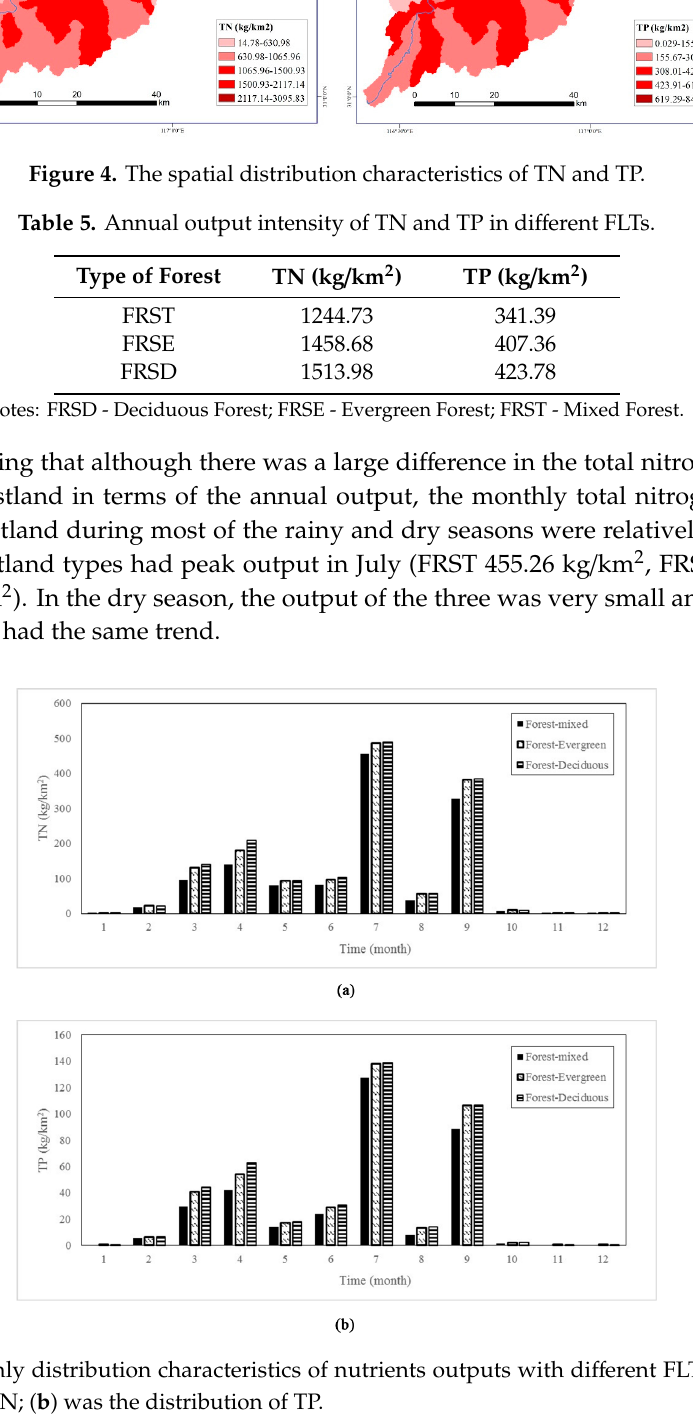
Figure 6. The relationship between nutrients outputs (TN and TP) and WFC.